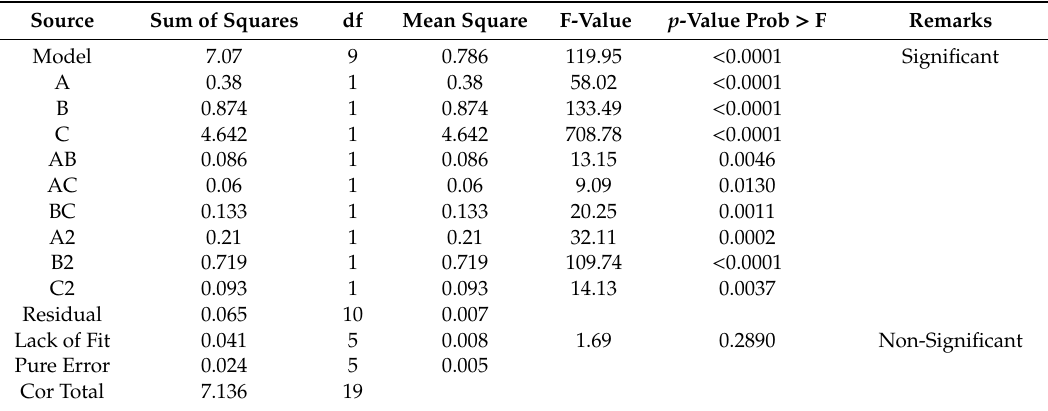
Table 3. ANOVA for response surface quadratic model on MC.